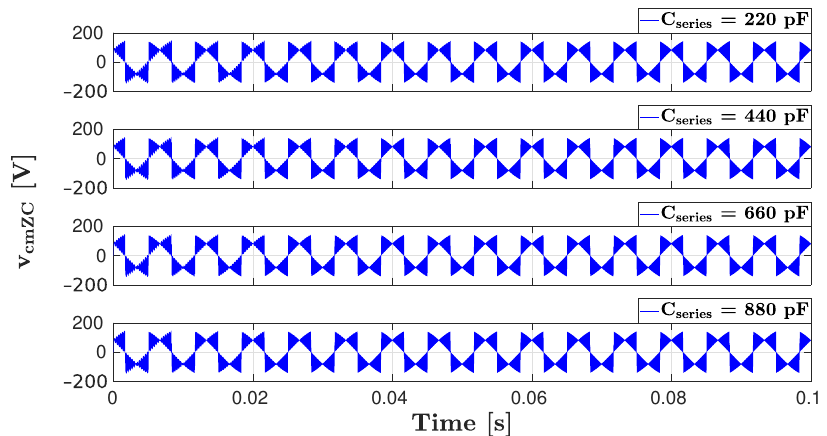
Figure 14. Waveforms of v cmZC with different values of C series .